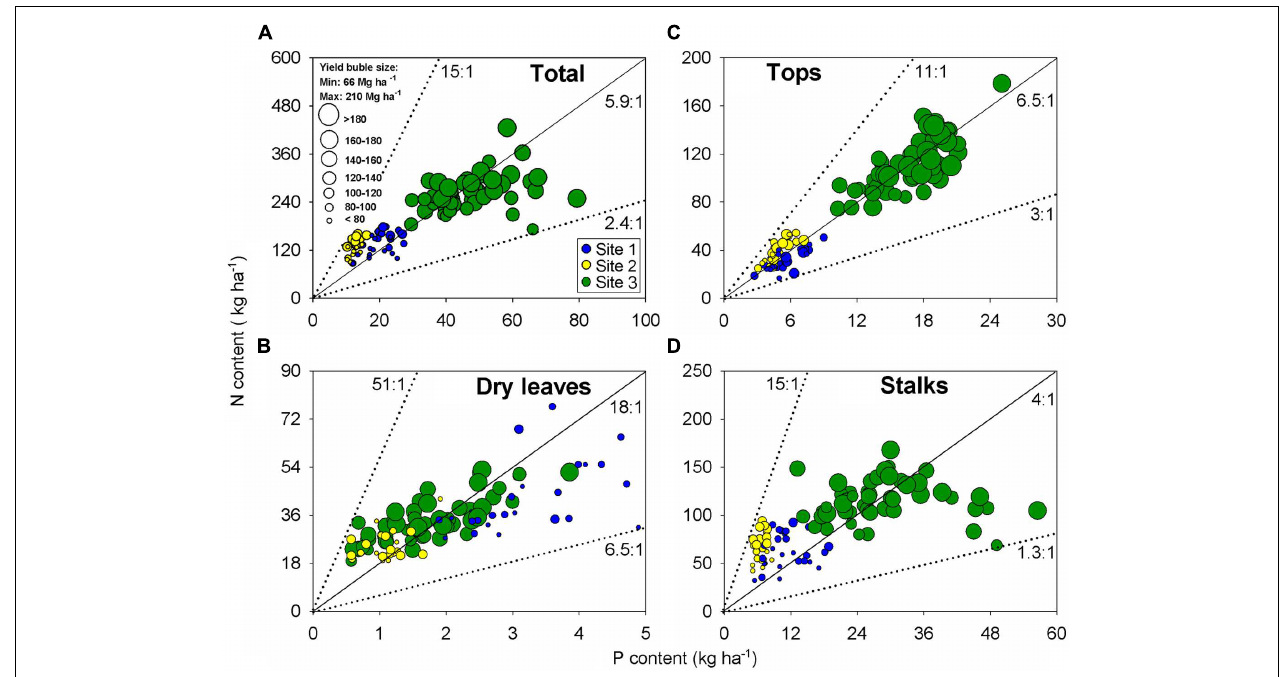
FIGURE 4 | Relationships between N versus P content for all plant components: aboveground biomass (A), dry leaves (B), tops (C), and stalks (D). Each data point represents an individual field plot at sugarcane harvest of a first ratoon growing season for three site-years ( n = 102). Dotted lines show boundary ratios for each component between N versus P, and black line shows the average